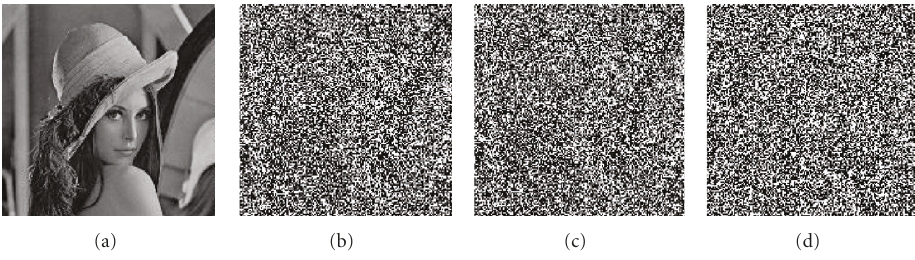
Figure 2: (a) Original Lena image. (b) Image corrupted by 70% noise density. (c) Image corrupted by 80% noise density. (d) Image corrupted by 90% noise density.